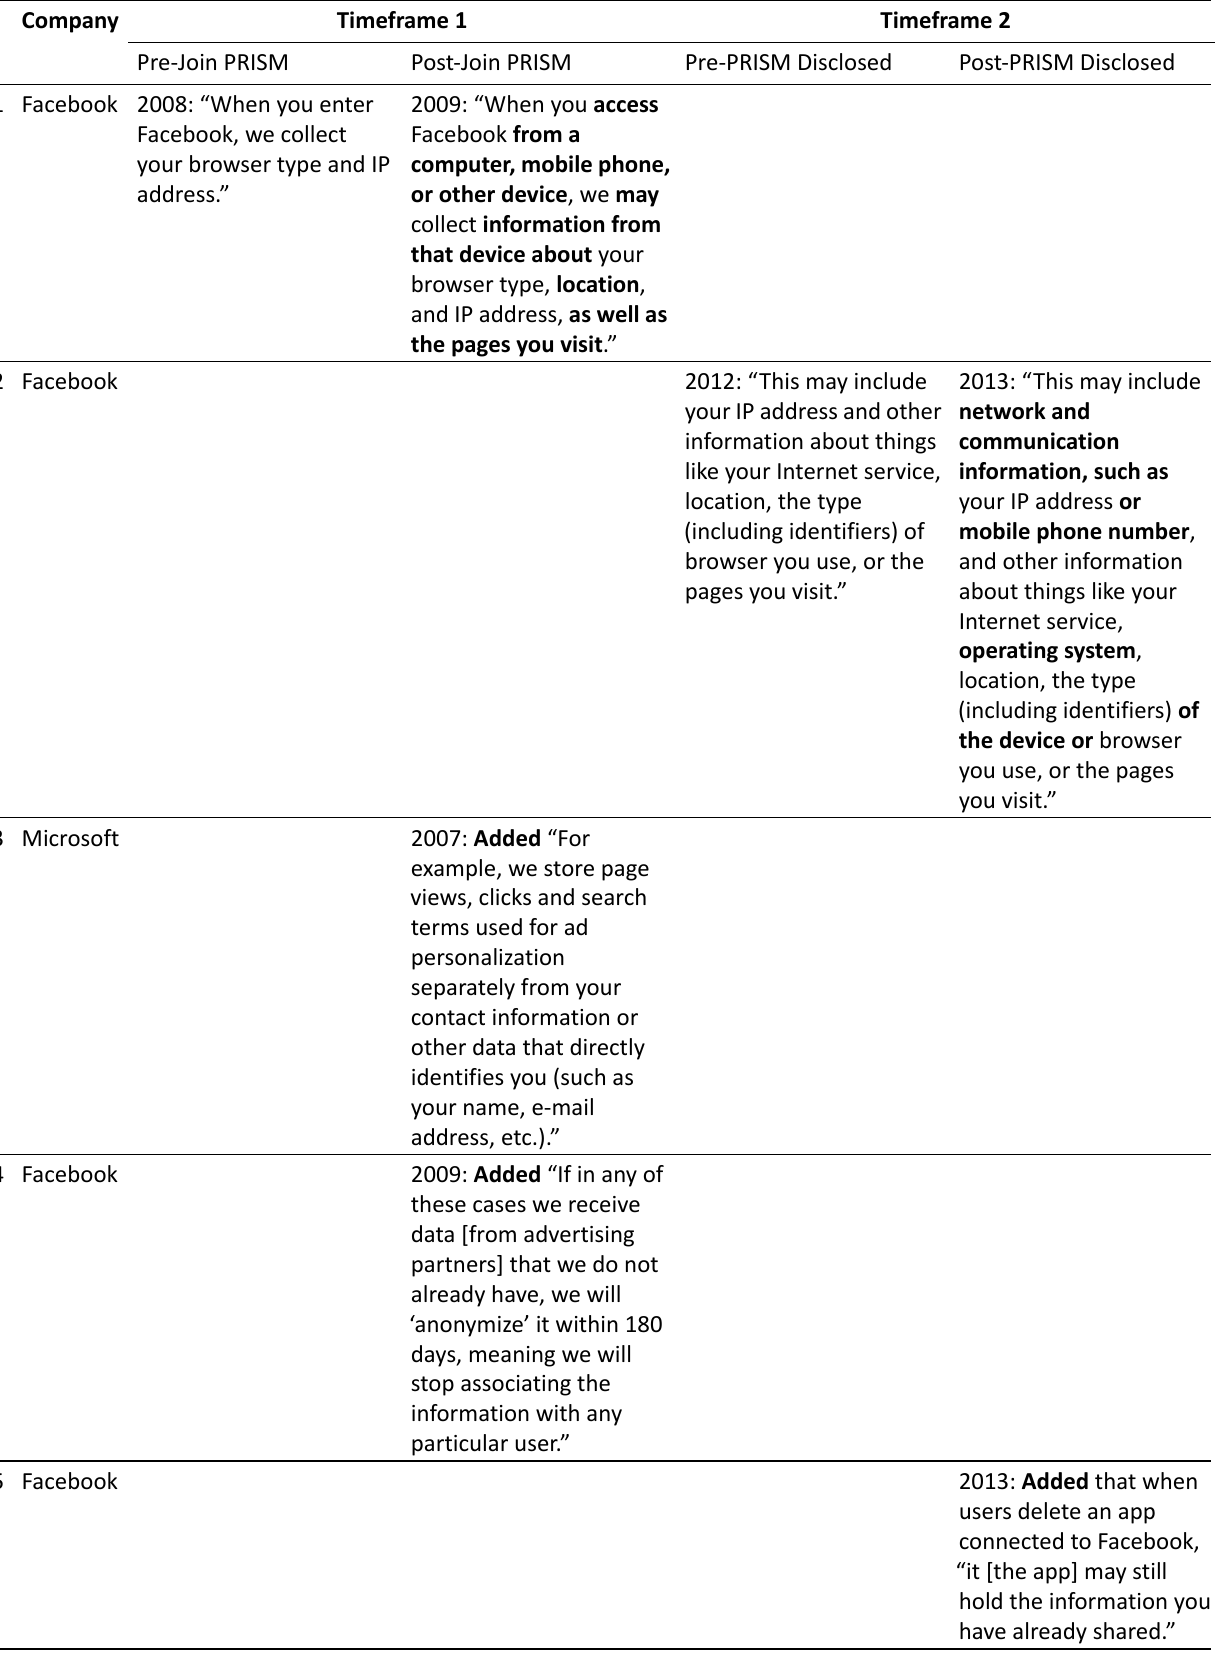
Table A.1. Privacy policy changes related to management of user